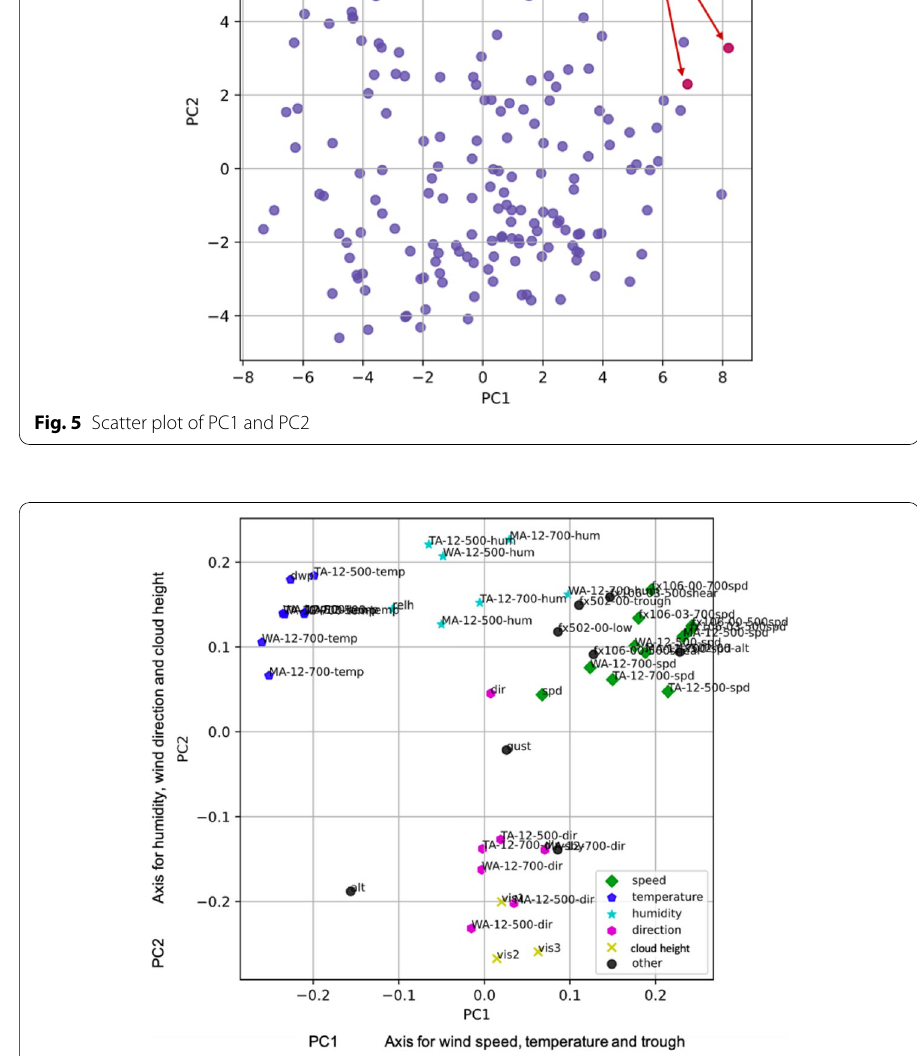
Fig. 6 Plot of each element on PC1 and PC2